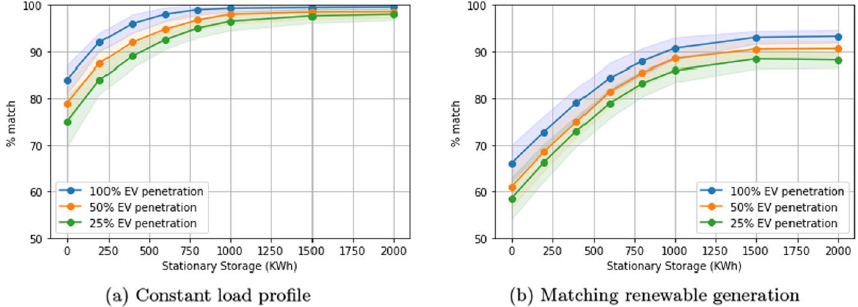
Fig. 8 Performance under lower levels of EV penetration over different levels of stationary storage. One-way charging in a residential